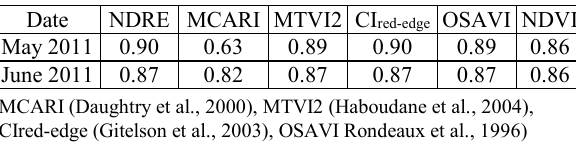
Table 1. Correlation coefficient (r) between CCC SPAD of winter wheat and selected vegetation indices (n=24 in May; n=18 in June; level of significance, p = 0.01).